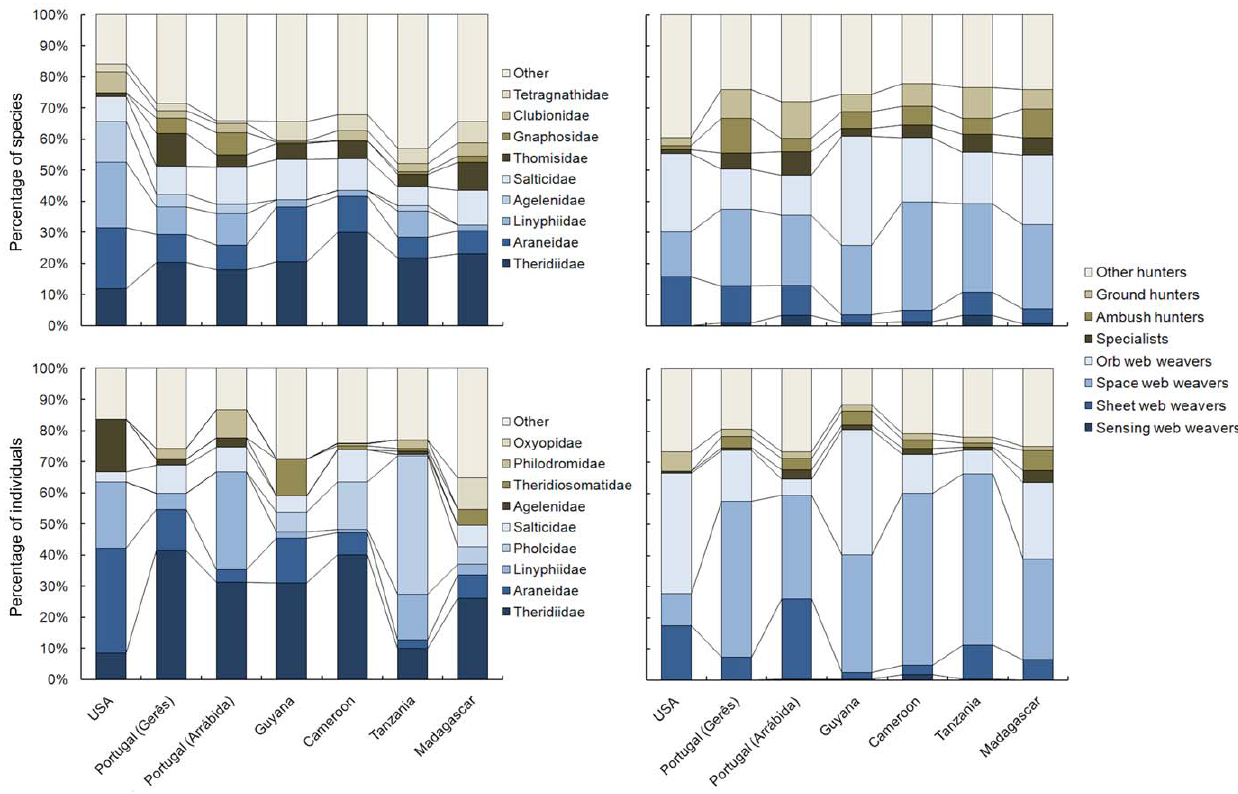
Figure 3. Percentage of species and individuals per family and guild in each studied site.